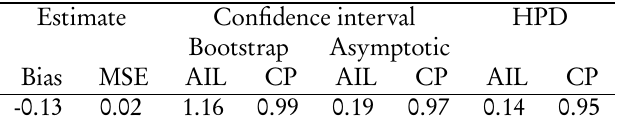
The bias and MSE for MLE and AIL and CP for CI for (cid:69) ( t ) .